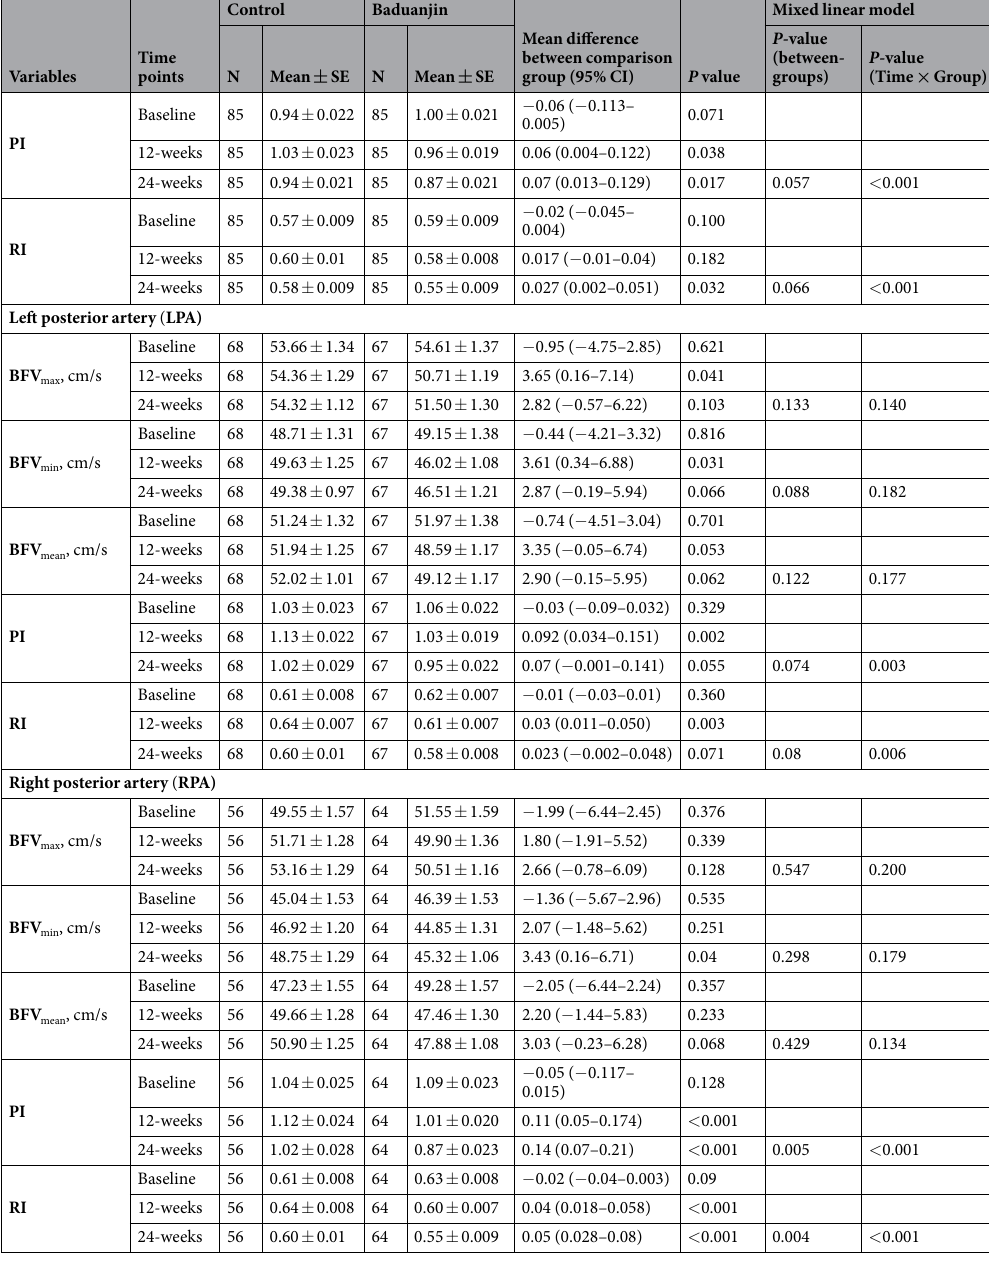
Table 3. Mean haemodynamic parameters of five cerebrovascular arteries at all time points. Abbreviations: BFV, blood flow velocity; PI, pulsatility index; RI, resistance